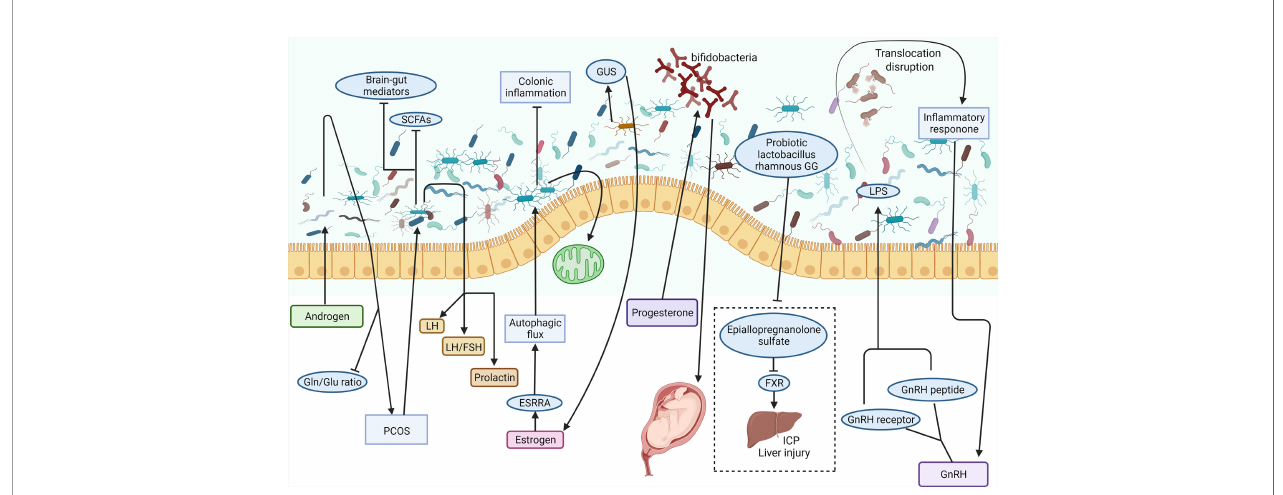
FIGURE 3 | Possible involving mechanisms of sex/sex-related hormones in the regulation of the gut-liver axis. The intestinal microbiome is a complex microbial ecosystem. Androgen induced dysbacteriosis may aggravate PCOS and reduce the circulating Gln/Glu ratio. The study on the effects of intestinal microorganisms on gut brain mediators and sex hormones in patients with PCOS showed that prolactin, LH and LH/FSH ratio increased signi fi cantly, while brain-gut mediators and SCFAs decreased. Estrogen can improve colitis and protect mitochondrial function by ESRRA-mediated autophagy. One of the main regulators of circulating estrogen is the intestinal microbiome via the secretion of GUS. Progesterone promotes the growth of bi fi dobacteria in the third trimester of pregnancy and transmits it to newborns. Probiotic Lactobacillus rhamnosus GG can prevent epicallopregnanolone sulfate-mediated FXR activation and bile acid synthesis, so as to reduce liver bile acid accumulation and liver injury in ICP patients. Dysfunction of intestinal microbiota may lead to LPS leakage, in fl ammatory response, and GnRH secretion abnormality. ESRRA, estrogen related receptor alpha; FSH, follicle-stimulating hormone; FXR, farnesoid X receptor; GnRH, gonadotrophin-releasing hormone; GUS, b -glucuronidase; ICP, intrahepatic cholestasis of pregnancy; LH, luteinizing hormone; LPS, lipopolysaccharide; PCOS, polycystic ovary syndrome; SCFA, short chain fatty acid (Created with Biorender.com with a publication